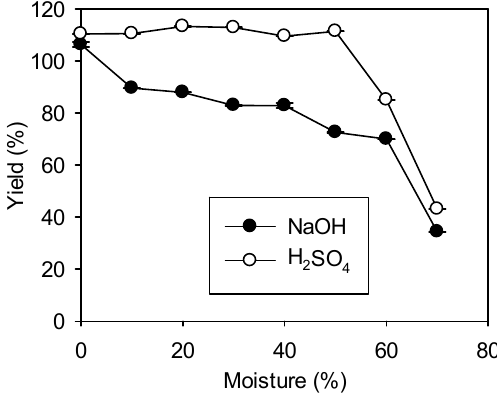
Figure 4. The effect of moisture on FAME yield. Direct transesterification on 1 g of dry R. glutinis biomass was carried out at 70 °C with 1 g/L NaOH and 0.6 M H 2 SO 4 for 10 and 20 h, respectively. A methanol loading of 1:20 (biomass: methanol, w / v ) was used for both catalysts. Data were obtained by averaging three individual measurements and the standard deviations were indicated with error bars.